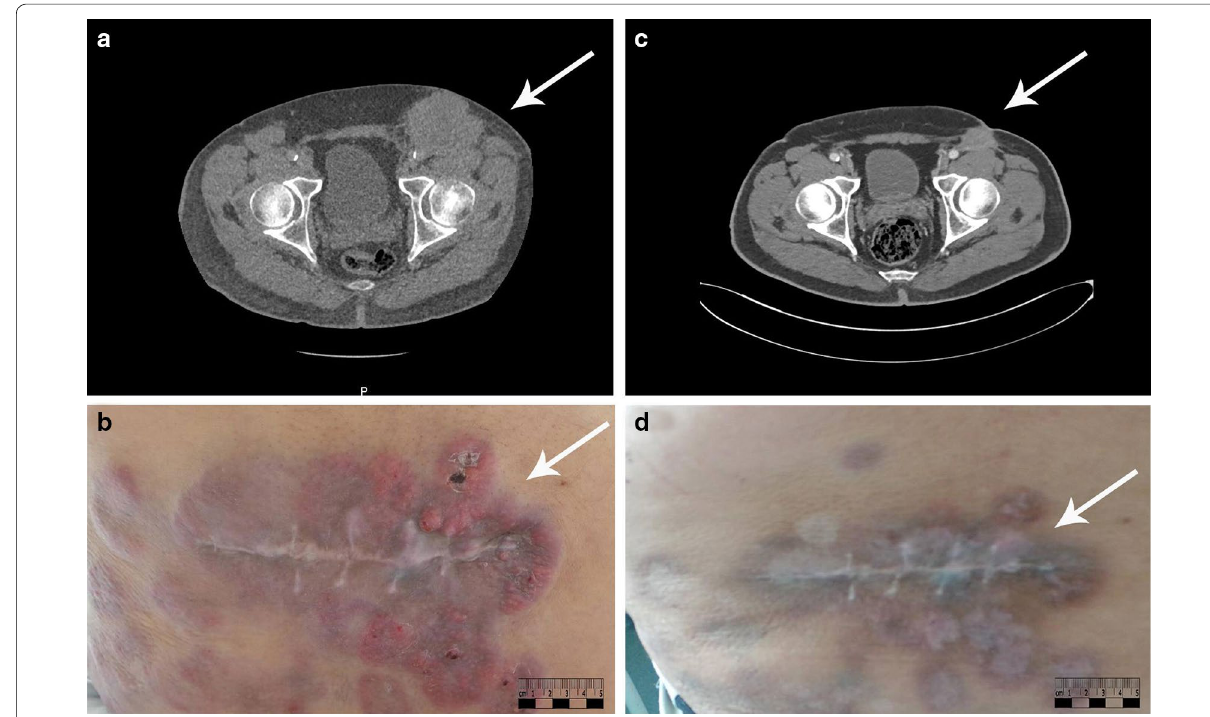
Fig. 1 Computed tomography (CT) and macroscopic images of the inguinal lesion before and after 3 cycles of chemotherapy . a CT scan shows a subcutaneous metastatic melanoma lesion ( arrow ) of 76 mm 63 mm in the left inguinal area before chemotherapy. b Cutaneous metastatic × melanoma lesions ( arrow ) were nodular and inflammatory before chemotherapy. c CT scan shows that the size of the subcutaneous metastatic